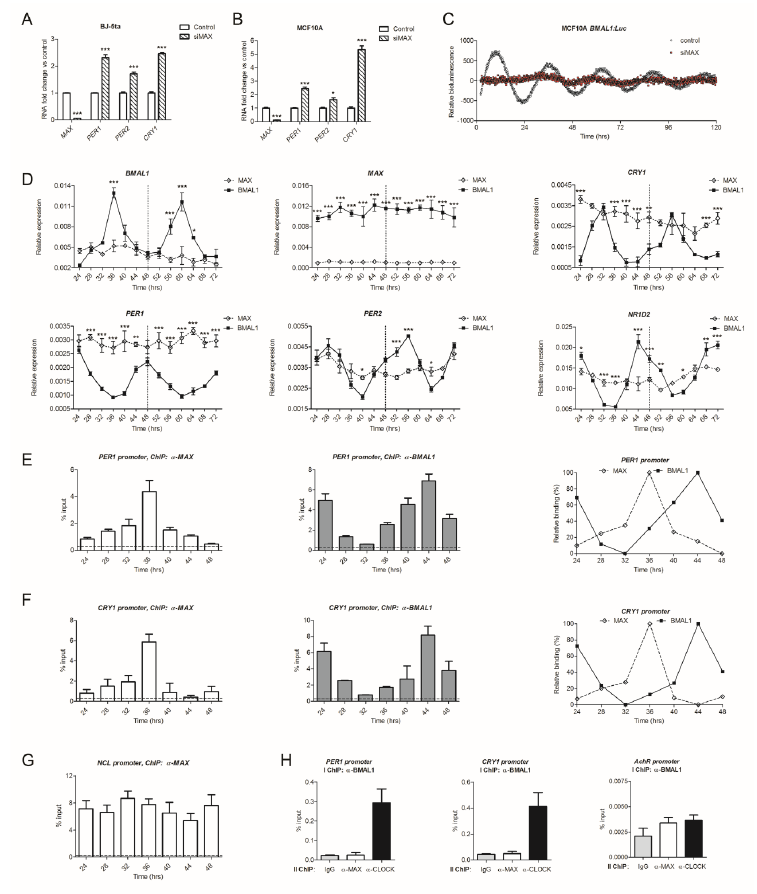
Figure 6. MAX is required for circadian gene expression. ( A , B ) Expression of MAX , PER1 , PER2 , CRY1 , and CRY2 genes upon MAX silencing in foreskin fibroblast BJ-5ta ( A ) and epithelial MCF10A ( B ) cell lines. Relative expression was determined by qRT–PCR using GAPDH for normalization. Values of control cells were set to 1. Shown as mean + SEM, n ≥ 3. * p < 0.05 and *** p < 0.001, two-way ANOVA with Bonferroni post hoc test, silencing versus control. ( C ) Bioluminescence counts from circadian synchronized MCF10A cells expressing a firefly luciferase reporter controlled by the circadian-responsive BMAL1 promoter with knocked down MAX (siMAX, red dots). Cells transfected with a non-coding control was used as a control (control, black dots). Shown as baseline-subtracted luminescence data fitted to a sine wave. ( D ) Time-related expression over two circadian cycles of endogenous clock-controlled genes in siMAX and control synchronized MCF10A cells. Relative expression at the indicated dexamethasone post-treatment time points was determined by qRT–PCR using GAPDH for normalization. Shown as mean + SEM, n = 3. * p < 0.05, ** p < 0.01 and *** p < 0.01, siBMAL1-silenced versus control cells, siMAX-silenced versus control cells, two-way ANOVA with Bonferroni post hoc test. ( E,F ) Recruitment of MAX and BMAL1 on the E-box-containing promoters of PER1 ( E ) or CRY1 ( F ) in MCF10A cells at the indicated post-synchronization time. Enrichment of MAX or BMAL1 was evaluated by quantitative PCR of immunoprecipitated DNA compared with input DNA (% of input). Immunoglobulin G (IgG) was used as a negative control. Normalized MAX and BMAL1 binding profiles are shown on the right panel for comparison (maximal and minimal values were normalized to 100 and 0, respectively). ( G ) Recruitment of MAX on the promoter of a non-circadian MAX target gene ( NCL ) at the indicated post-synchronization time. ( H ) The independent binding of MAX and BMAL1 to the clock-controlled promoters, PER1 and CRY1 , was evaluated by ChIP and Re-ChIP assays. Chromatin samples from non-synchronous MCF10A cells were first immunoprecipitated with an anti-BMAL1 antibody, and the recovered material was subsequently re-immunoprecipitated with IgG or with antibodies against MAX or CLOCK. A clock-independent promoter ( AchR ) was used as a negative control. Shown as mean + SEM, n =